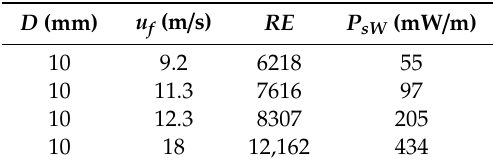
Table 8. Simulations results for the plate L = 75 mm, t p = 100 µ m.